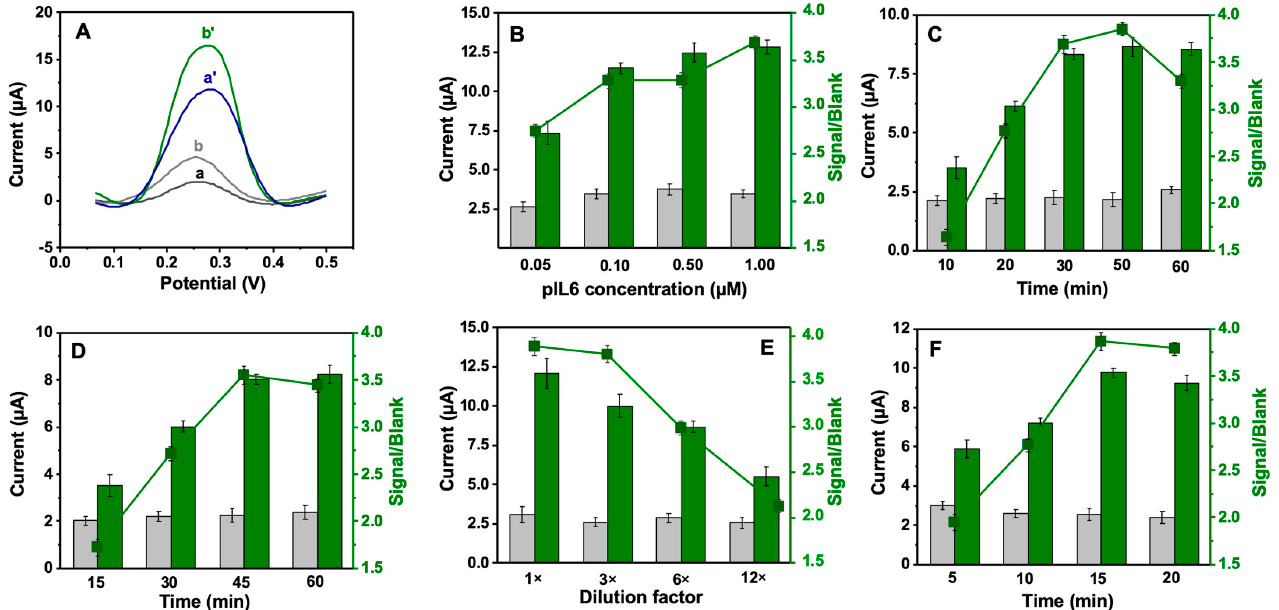
Figure 1. ( A ) SWV responses obtained in presence of the synthetic tIL6 sequence using MB (a and a’) and TMB (b and b’). Current and S/B ratio variation as function of the ( B ) pIL6 concentration, ( C ) incubation time of pIL6, ( D ) hybridization time of tIL6 sequence with pIL6/MBs, ( E ) dilution ratios of commercial TMB, and ( F ) incubation time into TMB solution. The ■ symbol represents the signal-to-blank ratio values for each measurement.